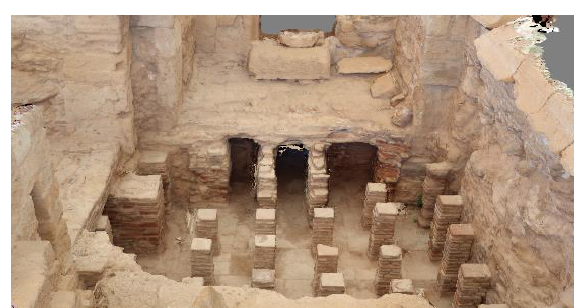
Figure 4. 3D Model of the hypocaust area, image based reconstruction